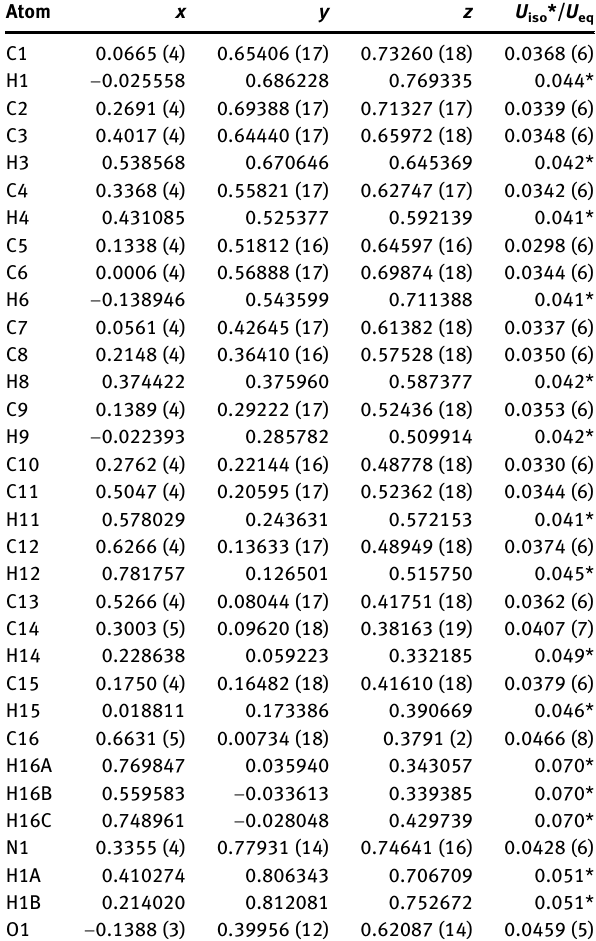
Table  : Fractional atomic coordinates and isotropic or equivalent isotropic displacement parameters (Å 